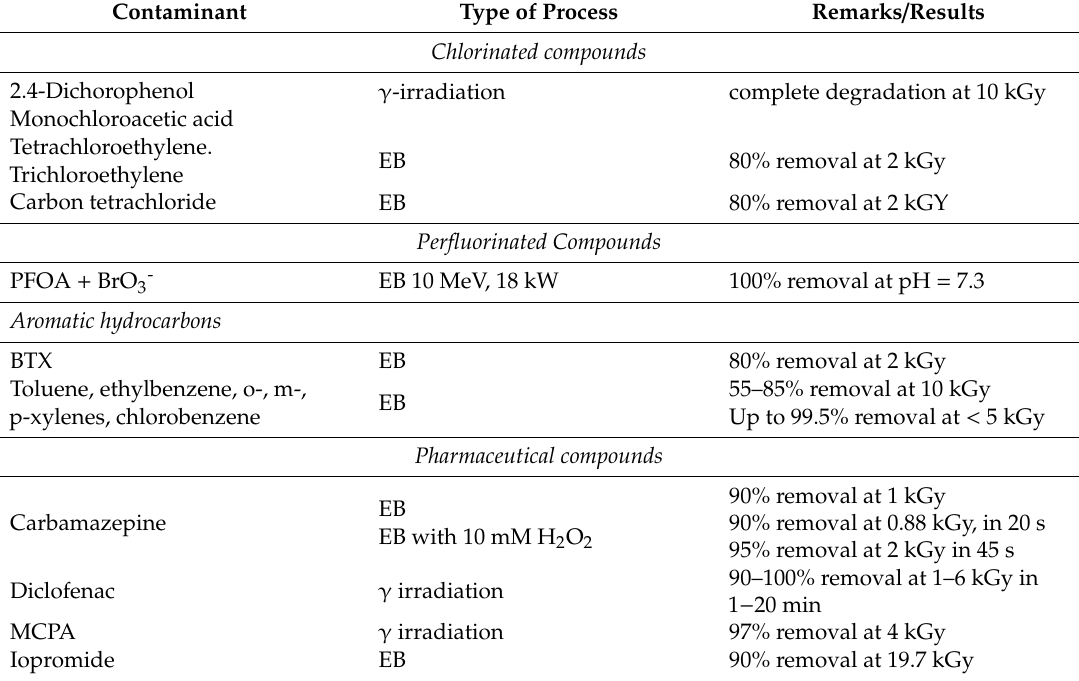
Table 8. Application of AORPs for the removal of di ff erent types of compounds. Data from